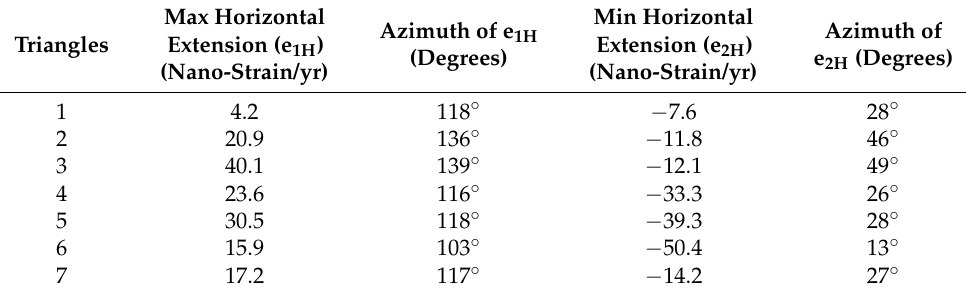
Table 3. The values and azimuths of the strain axes based on the geodetic strain rate.